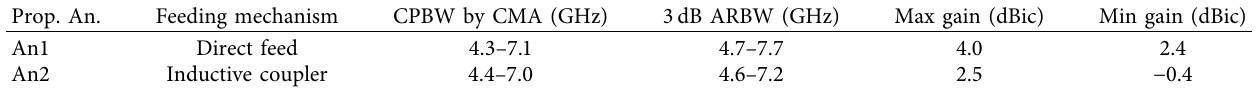
Table 3: Comparison between An1 and An2.